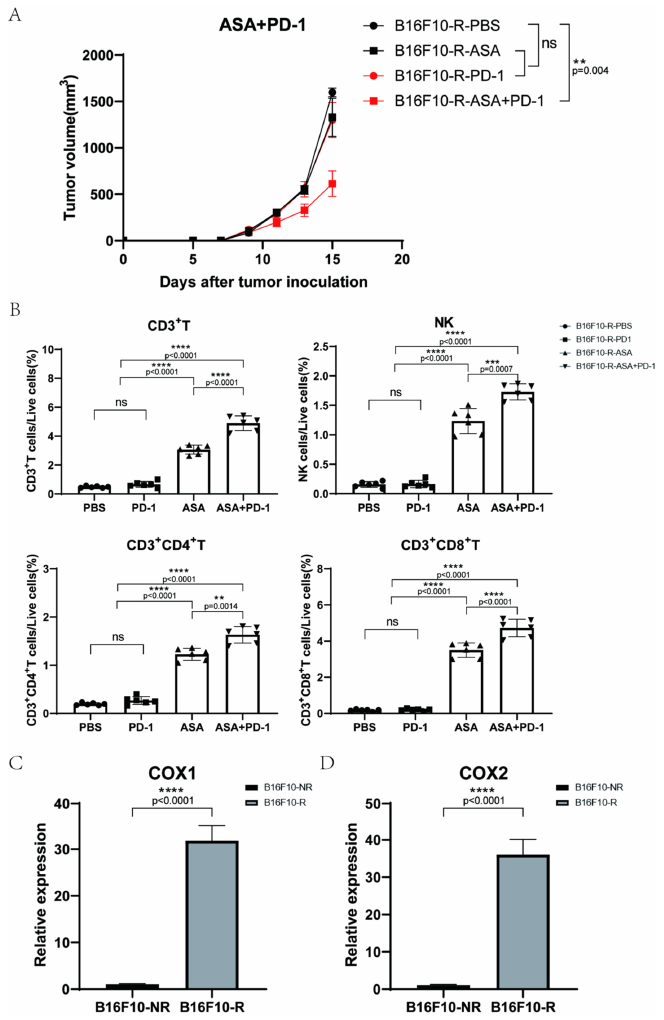
Figure 3. Effects of aspirin combined with pembrolizumab on B16F10-R tumour growth in vivo. ( A ) Growth curves of B16F10-R tumours in vivo treated with pembrolizumab, ASA, or PBS ( n = 6–8/group, two-way ANOVA test, Tukey). ( B ) Differences in the number of infiltrating lympho- cytes in B16F10-R tumours treated with ASA (one-way ANOVA test, Tukey). ( C , D ) RT-PCR analysis of ptgs1 ( C ) and ptgs2 ( D ) mRNA expression in B16F10-NR and B16F10-R tumours. GAPDH mRNA expression was used as the control ( n = 8/group, unpaired, two-tailed t test); ns, not statistically significant; ** p < 0.01; *** p < 0.001; **** p <